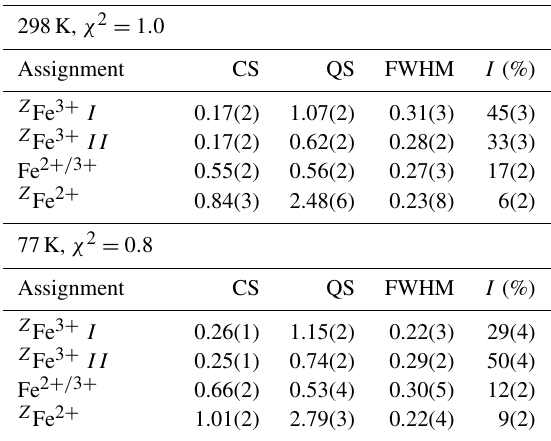
Table 3. Mössbauer hyperfine parameters for monteneveite, at 298 and